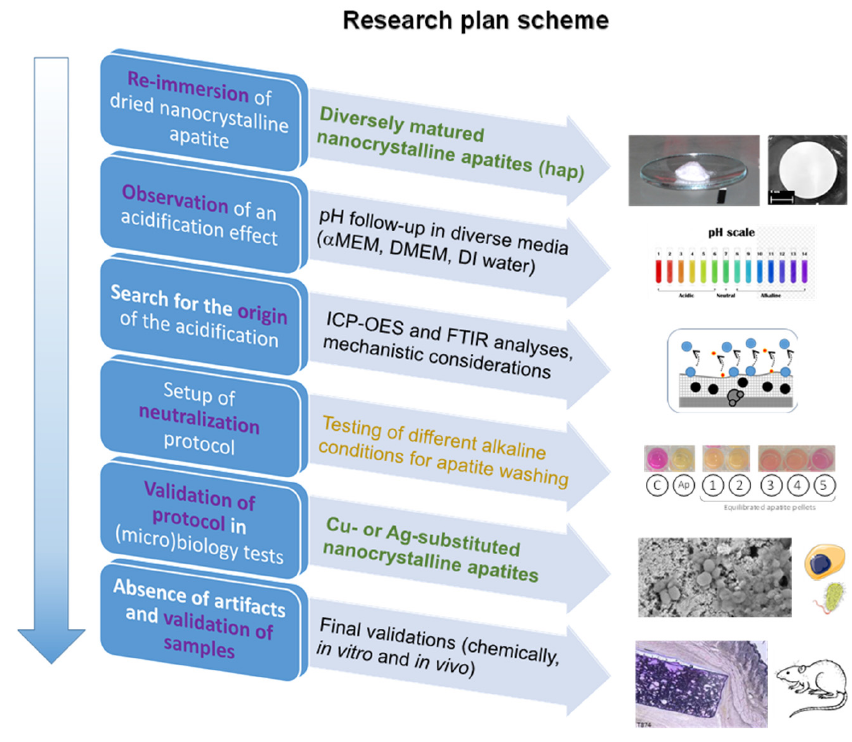
Figure 1. Overview of the research plan followed in this